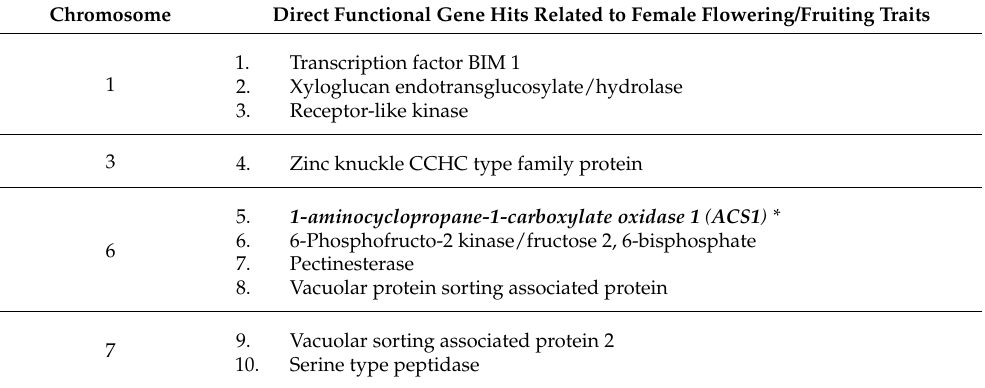
Table 5. Number of functional hits for the male-allele-specific SNPs across the Cucurbit Genomics